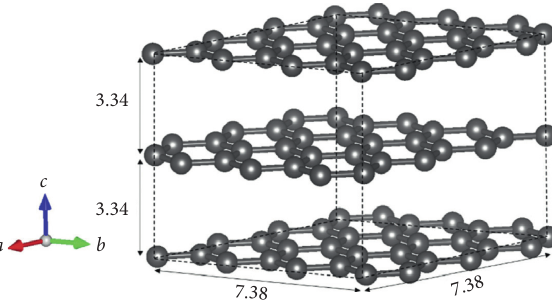
Figure 2: Geometry of perfect matrix graphite (0001) surface model obtained by full